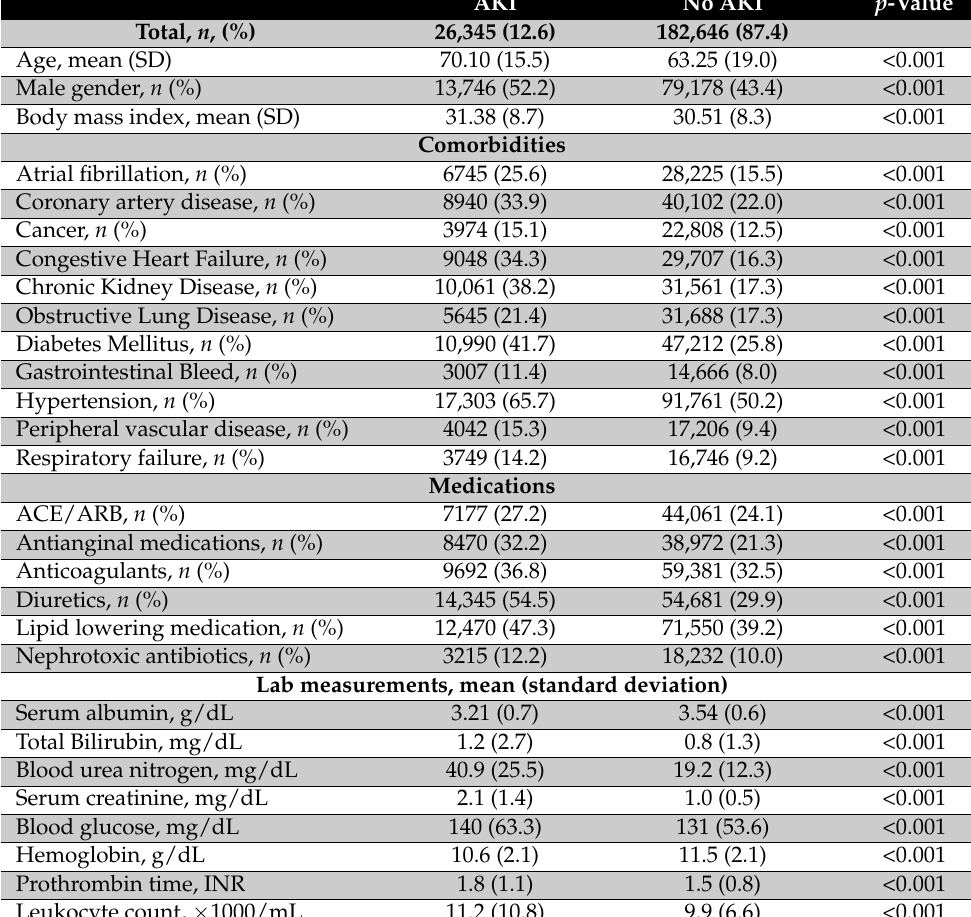
Table 2. Characteristics of patients who developed AKI compared to those who did